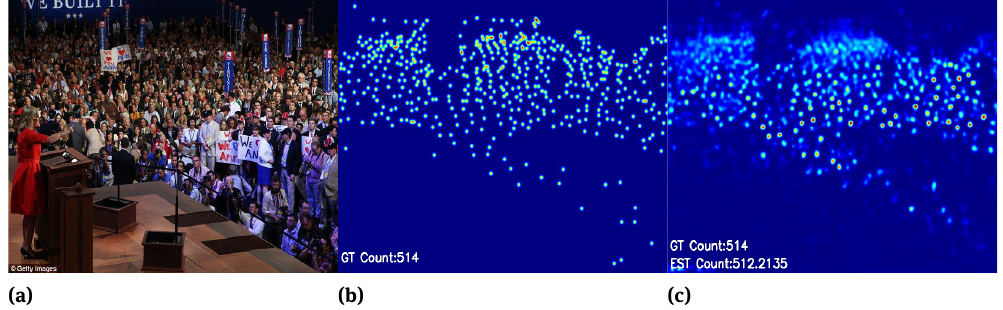
Figure 1: The proposed method results, (a) input image (the part_A from ShanghaiTech dataset), (b) ground density map, (c) estimated density map via our proposed